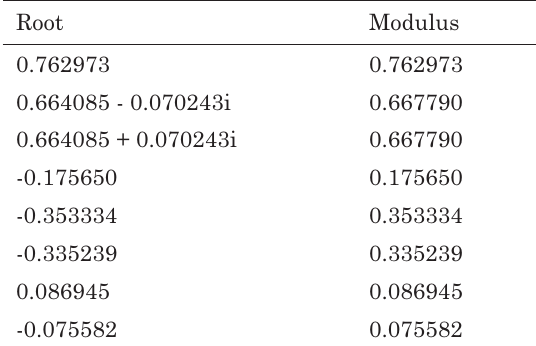
Table 3. Eight capital cities’ house price